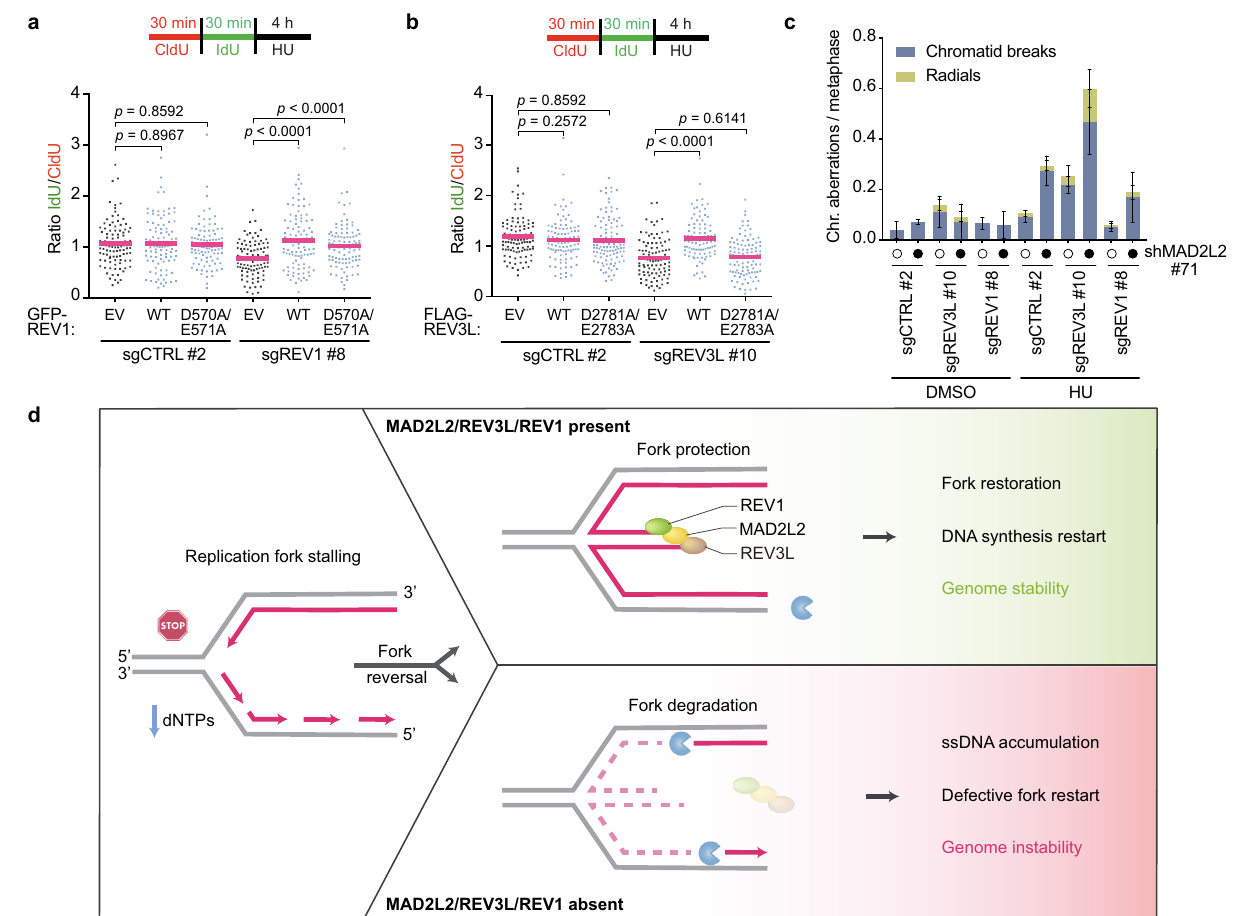
Fig. 7 | MAD2L2, REV1 and REV3L polymerase activity are required for repli- cation fork protection and genome maintenance. a Schematic and quanti fi ca- tion of fork degradation assays in control (sgCTRL) and REV1-depleted HeLa cells complemented witheither empty vector(EV),GFP-taggedwild-type REV1(WT), or GFP-tagged catalytic inactive mutant REV1 (D570A/E571A). A representative fi ber experiment from three independent biological replicates is shown. b Schematic and quanti fi cation of forkdegradationassays in control and REV3L-depleted HeLa cells complemented with either empty vector (EV), FLAG-tagged wild-type REV3L (WT), or FLAG-tagged catalytic inactive mutant REV3L (D2781A/E2783A). A repre- sentative fi ber experiment from three independent biological replicates is shown. Pink bars in fi ber plots represent the mean. Statistical analysis in ( a , b ) was per- formed according to two-tailed Mann-Whitney test. Additional replicates and combined fi ber plots are provided in the Supplementary Information. c Quanti fi - cation of chromosomal aberrations in control, REV1- and REV3L-depleted HeLa